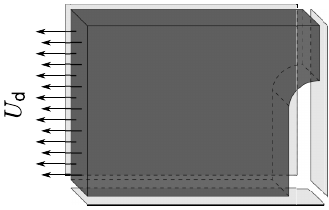
Figure 2. A plate with a central groove subjected to cyclic loading.